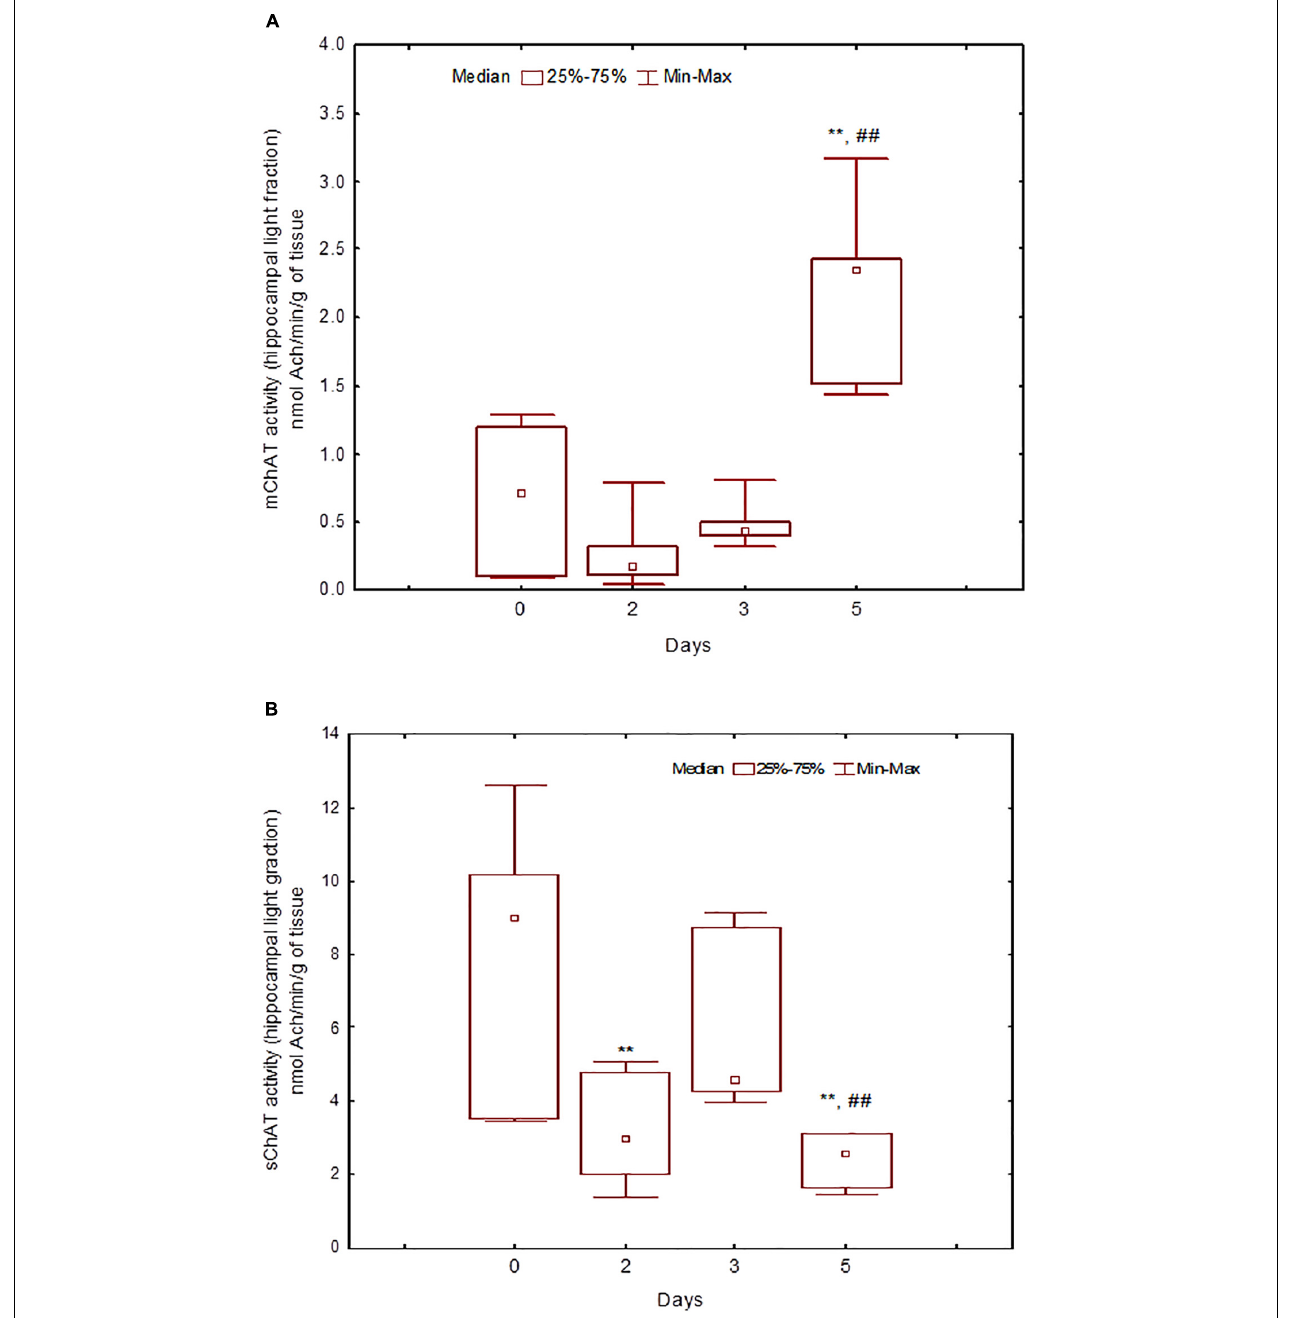
FIGURE 7 | Choline acetyltransferase (ChAT) activity in light synaptosomal sub-fractions from the hippocampus in naïve rats (day 0) and after 2, 3, or 5 days of training in the Morris water maze (MWM). (A) mChAT from light synaptosomal fraction, (B) sChAT from light synaptosomal fraction, ** p < 0.01 relative to naïve rats. ## p < 0.01 relative to the previous time